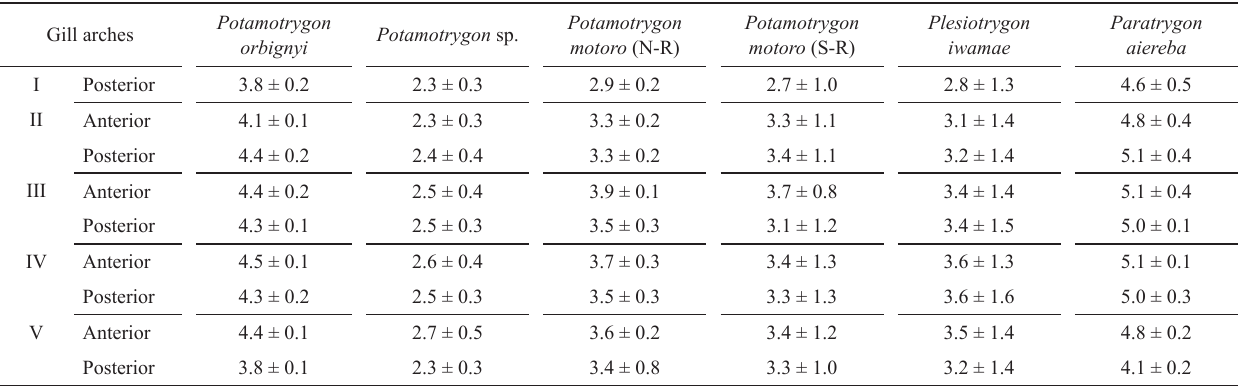
Table 3. Mean filament length (mm) (mean ± S.E) on different gill arches among near-term potamotrygonid embryos. Potamotrygon Gill arches Potamotrygon sp. orbignyi